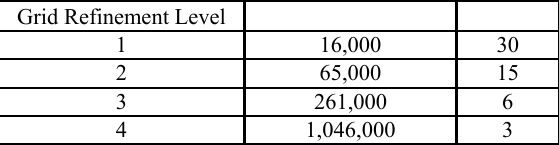
Table 1. Mesh size ( N ), wall spacing ( y t + ), and aspect ratio ( AR ) are used in mesh refinement study simulations. The mesh aspect ratio ( AR ) was held constantan the refinement